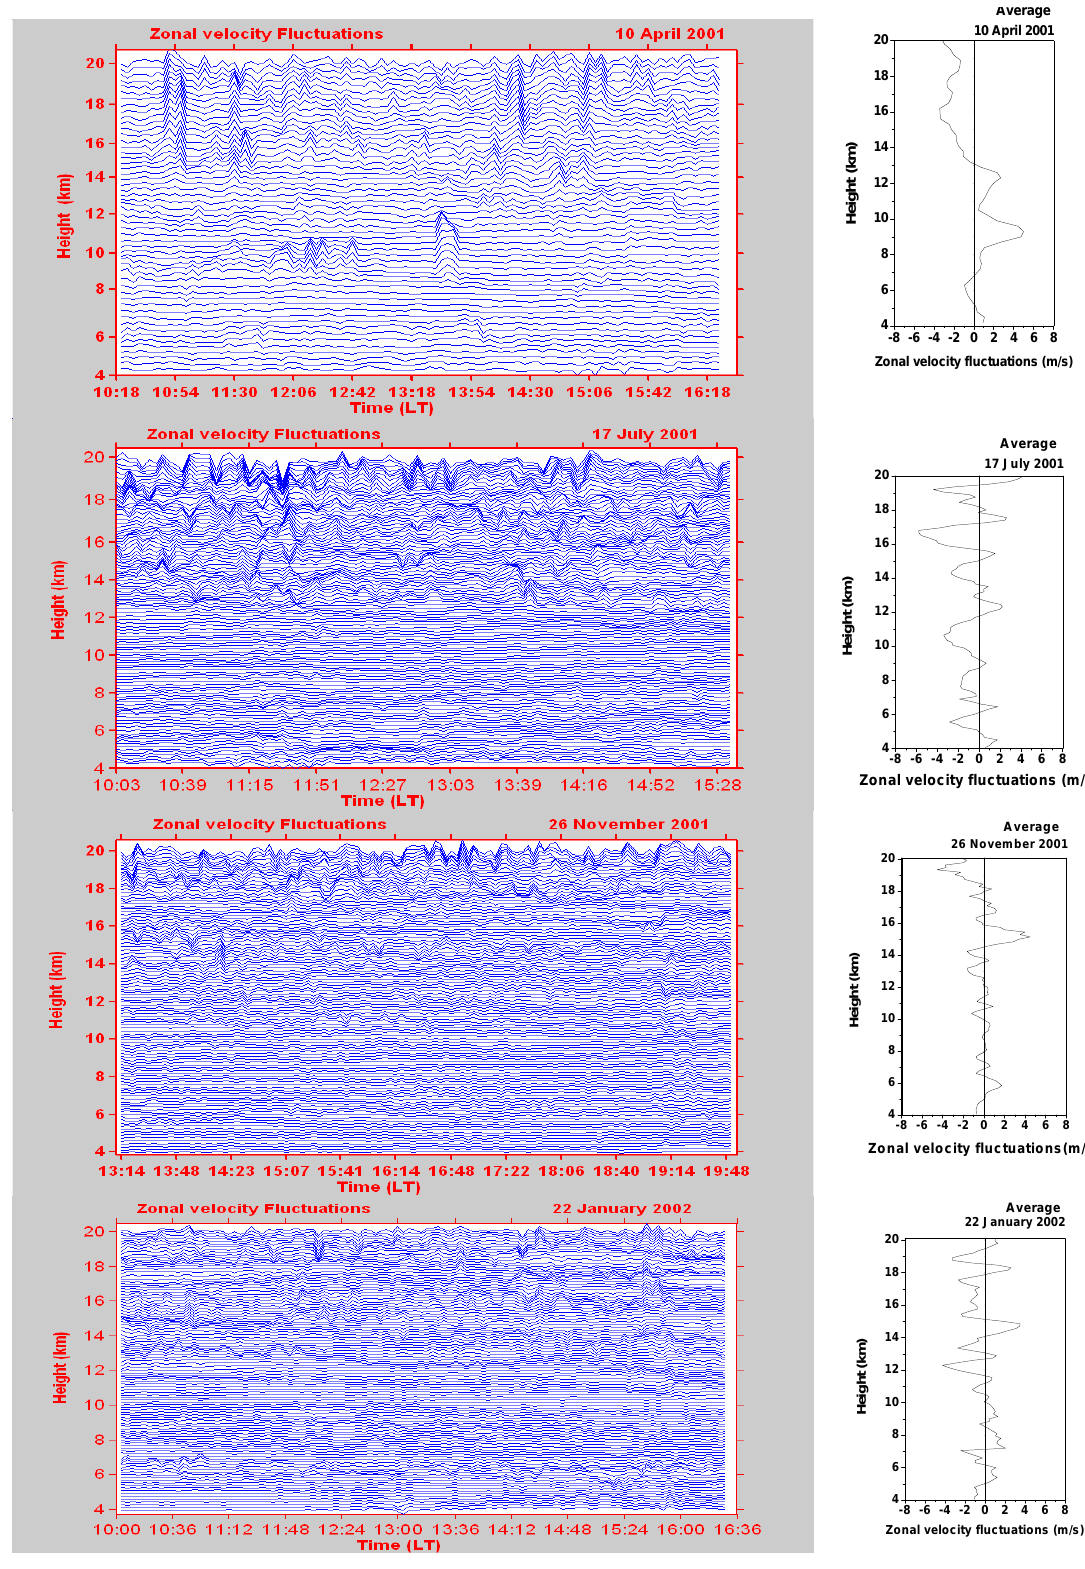
Fig. 3. Fig. 3. Height-time variation of zonal velocity fluctuations obtained by removing the background wind velocity at each height for a typical day, observed 6h with Indian MST Radar during 10 April 2001, 17 July 2001, 26 November 2001 and 22 January 2002. Successive profiles are displaced by 4m/s, 2m/s, 3m/s and 3m/s,